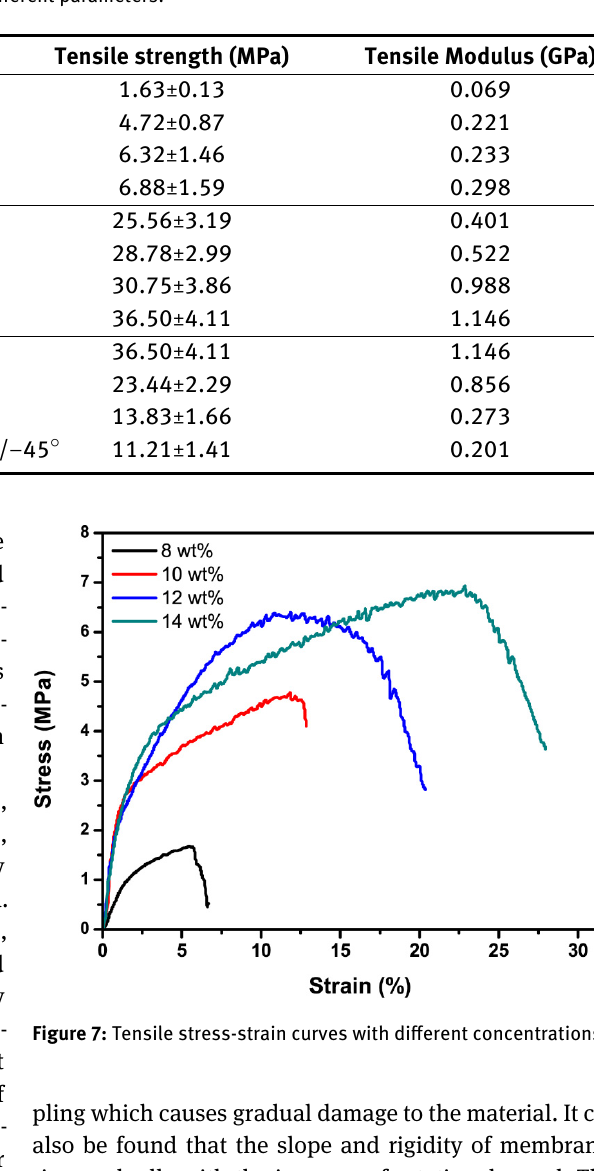
pling which causes gradual damage to the material. It can also be found that the slope and rigidity of membranes rise gradually with the increase of rotational speed. This content of the fibers along the loading